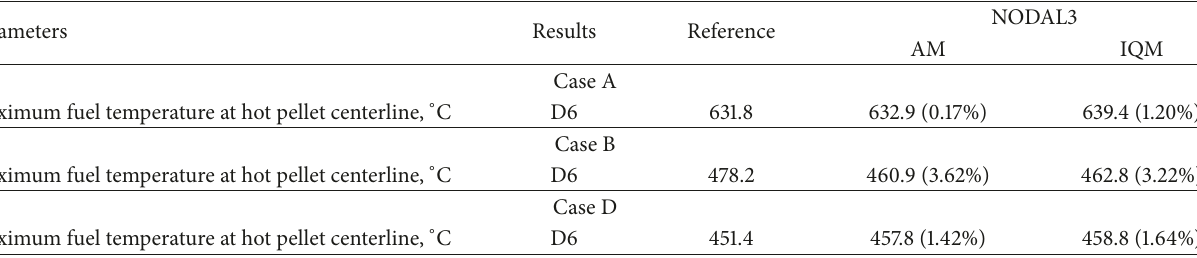
Table 7: Transient fuel pellet results for Cases A, B, and D.